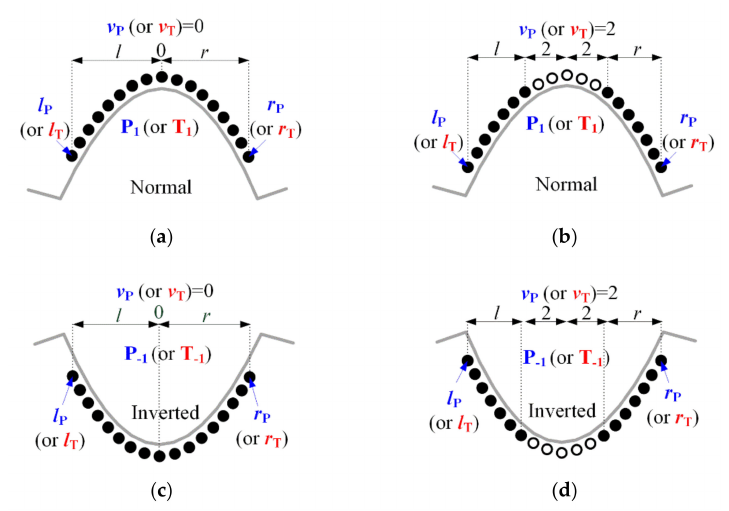
Figure 9. Symmetric point filters for normal and abnormal P- and T-point detection; ( a ) normal type ( ω = 1, v P = v T = 0), ( b ) deformed normal type ( ω = 1, v P = v T = 2), ( c ) inverted type ( ω = − 1, v P = v T = 0), and ( d ) deformed inverted type ( ω = − 1, v P = v T =